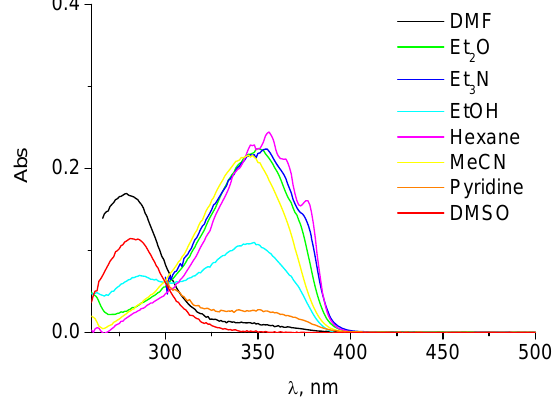
Figure 2. Absorption spectra of 2 in different solvents (concentration ca. 10 -5 M).